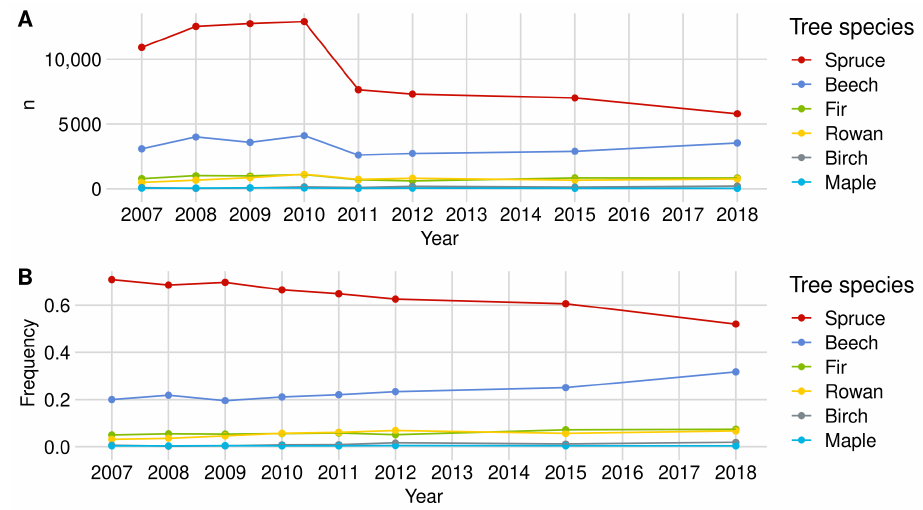
Figure A3. Sample size development of the main tree species over time in the RLG in ( A ) total numbers (n) and ( B ) relative